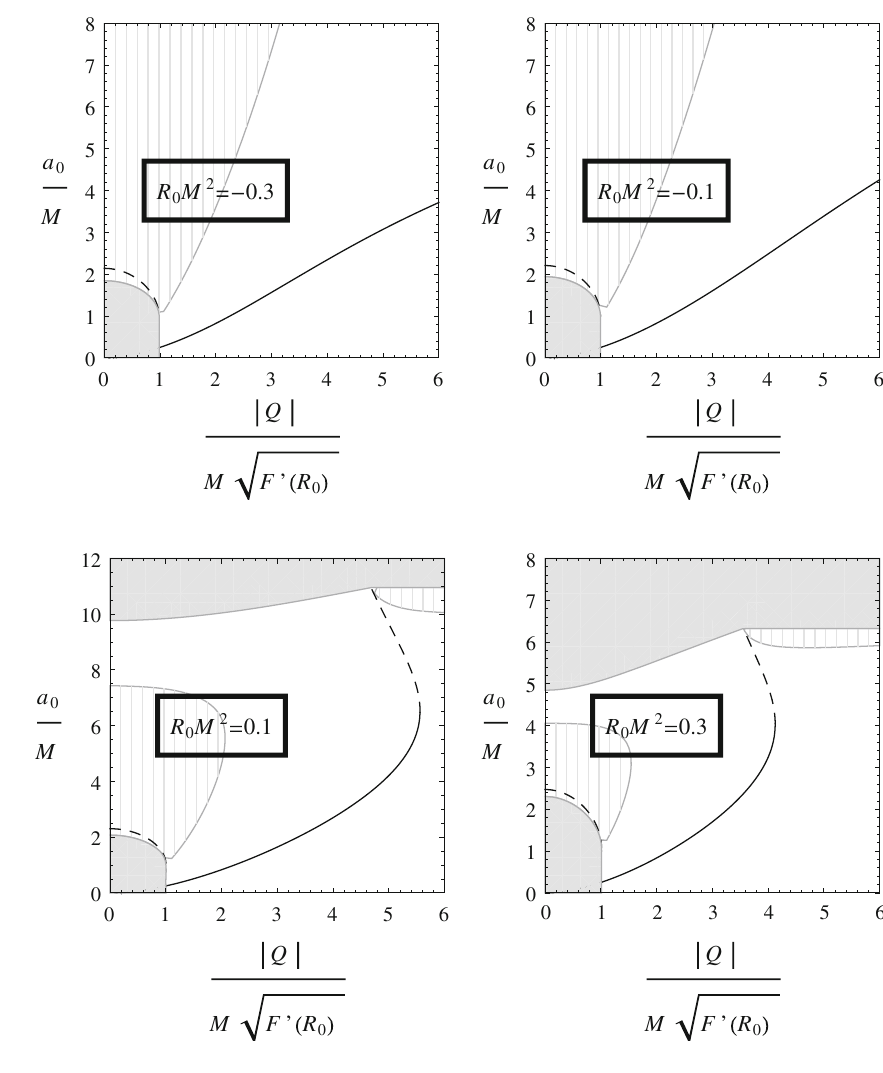
Fig. 1 Stability of bubbles in F ( R ) theories for different values of curvature scalar R 0 . Solid curves represent stable static solutions with radius a 0 , while dotted curves represent unstable ones. The mass M and the charge Q correspond to the geometry of the outer region. The meshed zones correspond to matter satisfying the weak energy condition and the gray ones are non-physical